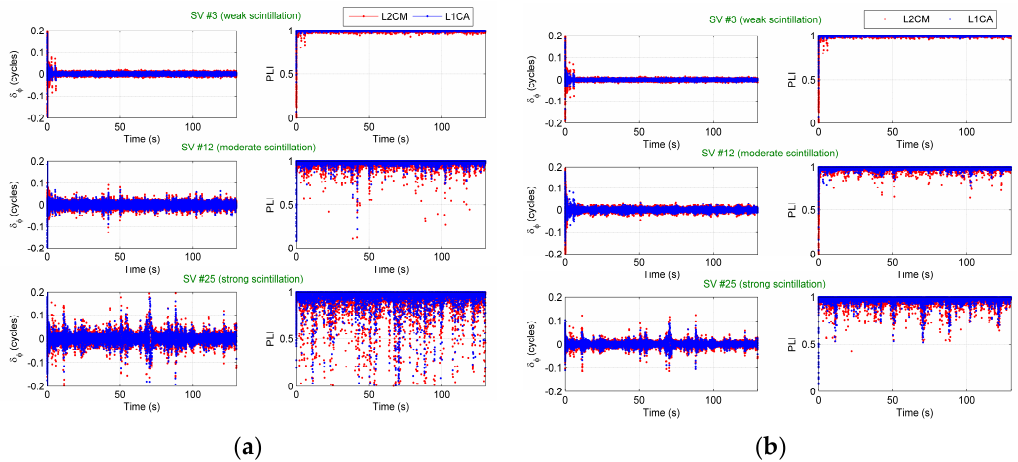
Figure 7. Carrier phase error and phase lock indicator (PLI): ( a ) Traditional GNSS tracking loop (T-